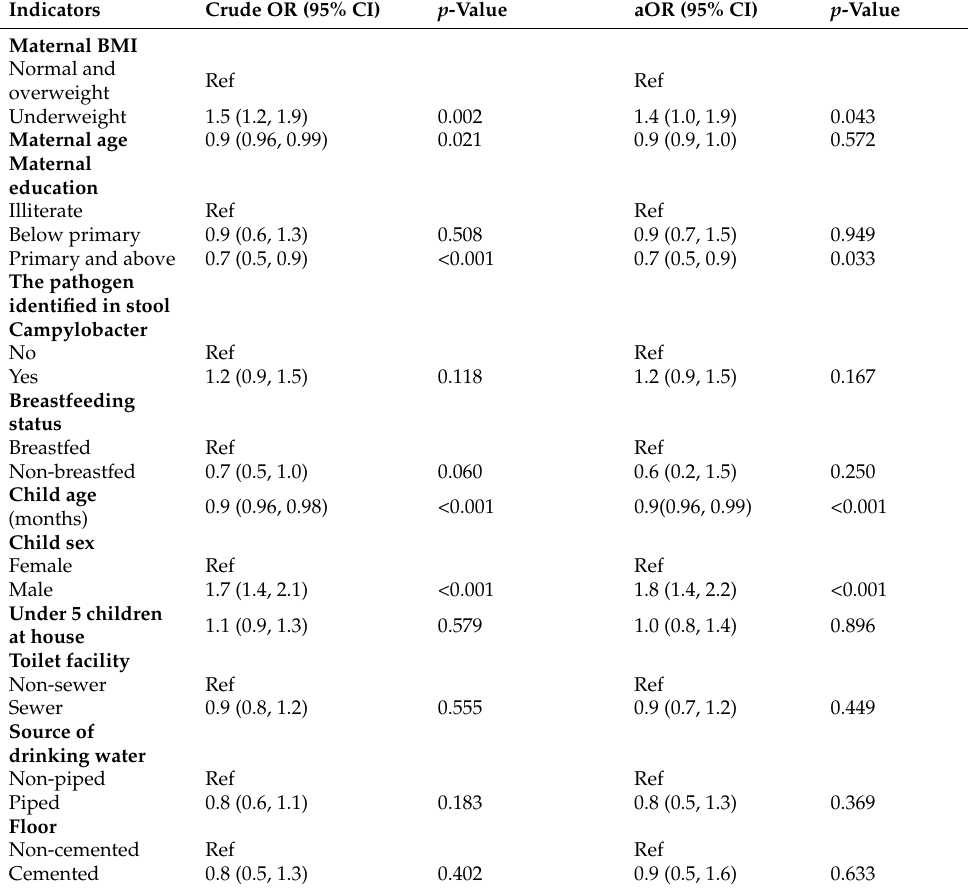
Table 4. Factors associated with the CIAF (no failure as the reference group).